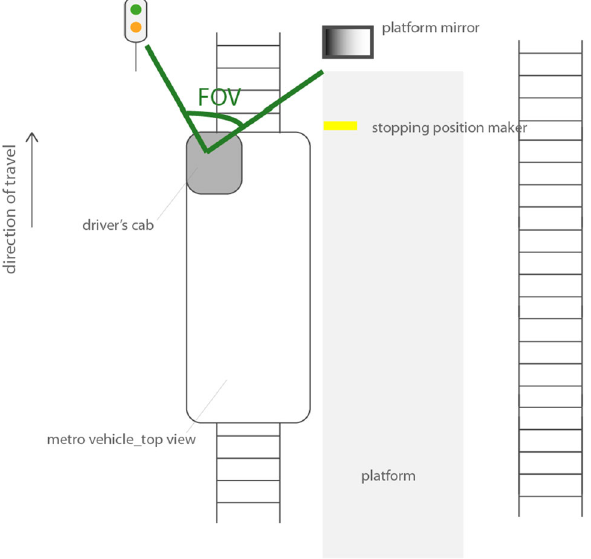
Fig. 4 Field of view (FOV)